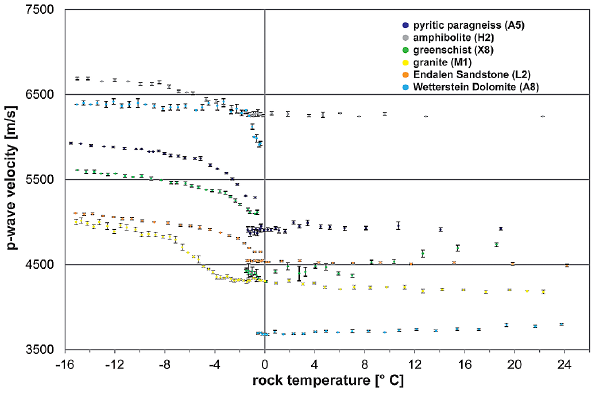
Fig. 2. P-wave velocity of several rock samples measures parallel to cleavage or bedding plotted against rock temperature; error bars indicate mean deviation of p-wave